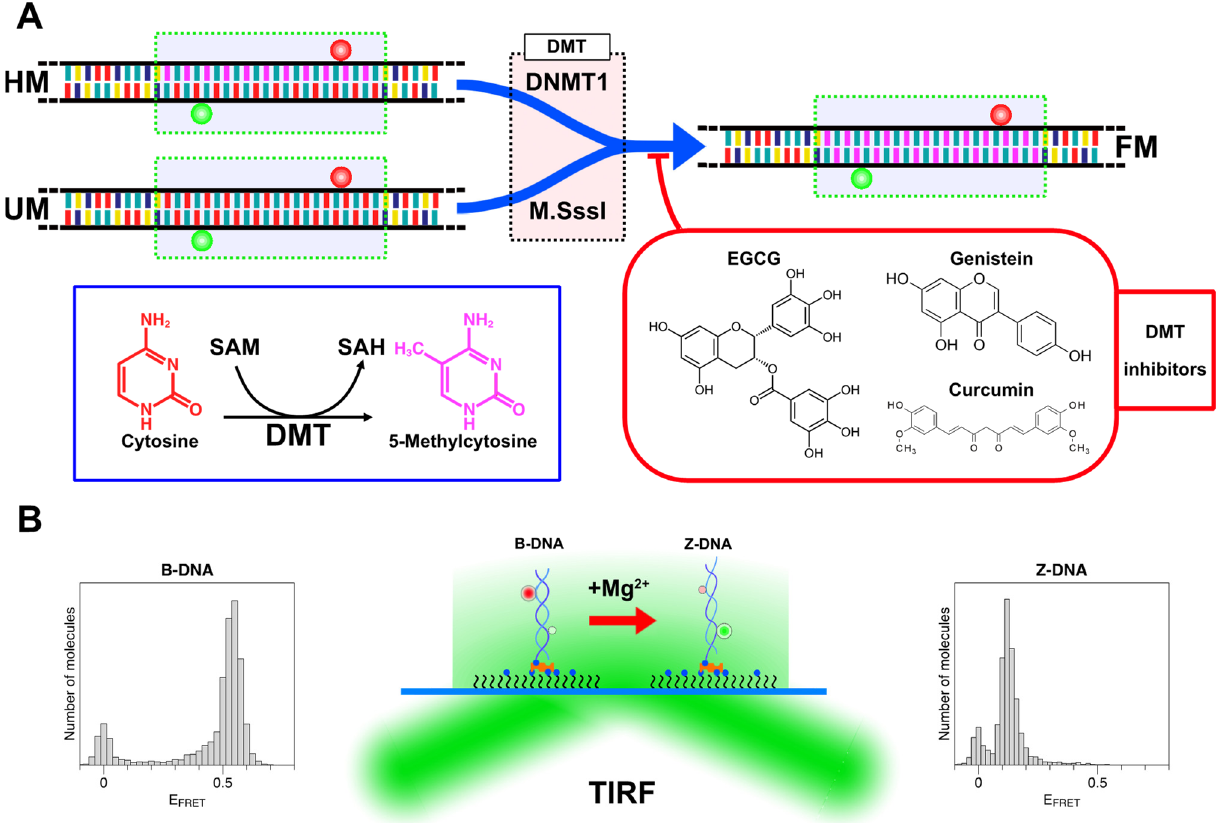
Figure 4. ( A ) Sample designs and main reactions of this work. DNA tether molecules with a 22-bp CpG repeat (green dotted box) with various degrees of cytosine methylation (bases are color-coded; A: yellow; T: indigo; G: teal; C: red; and mC (methylcytosine): purple) were prepared by hybridizing two dye-labeled complementary oligonucleotides (Cy3 (green ball) and Cy5 (red ball) on each oligonucleotide; FRET dye pairs were separated by 14 base pairs; See Supplementary Materials, Table S1, for sequence information) with a specific number of methylcytosines. Hemi-methylated (HM) and unmethylated (UM) molecules were the substrates for, and converted to, full methylated molecules (FM) by DNMT1 and M.SssI, respectively. DNA molecules were treated with DNA methyltransferases (DMT: DNMT1 or M.SssI) in a test tube. DMT enzymes changed cytosines (red) to methylcytosines (purple) by converting SAM to SAH and increased the degree of cytosine methylation in the DNA substrates as shown in the blue box. The reaction mixture was supplemented with one of the natural DMT inhibitors (EGCG, curcumin, or genistein) as shown in the red box. ( B ) Experimental setup and single-molecule detection strategy. Dye-labeled DNA tethers immobilized in the sample chamber are imaged in a TIRF microscope to measure FRET efficiency. The B-Z transition occurring to methylated DNA can be detected via a change in FRET efficiency in Mg 2+ -rich solutions. Representative FRET efficiency histograms for B-DNA (with low [Mg 2+ ]; E FRET ~ 0.5) and Z-DNA (with high [Mg 2+ ]; E FRET ~ 0.15) are shown as well. HM, UM, and QM tethers were immobilized on a glass substrate with biotin (blue ball) labeled at the 3 ′ end of the Cy3-labeled oligonucleotide while TM and FM tethers were immobilized via a biotinylated PCR fragment, which was ligated to the overhang (GATC) from the Cy5 labeled oligonucleotide (CG1 or methylated CG1) of TM or FM.